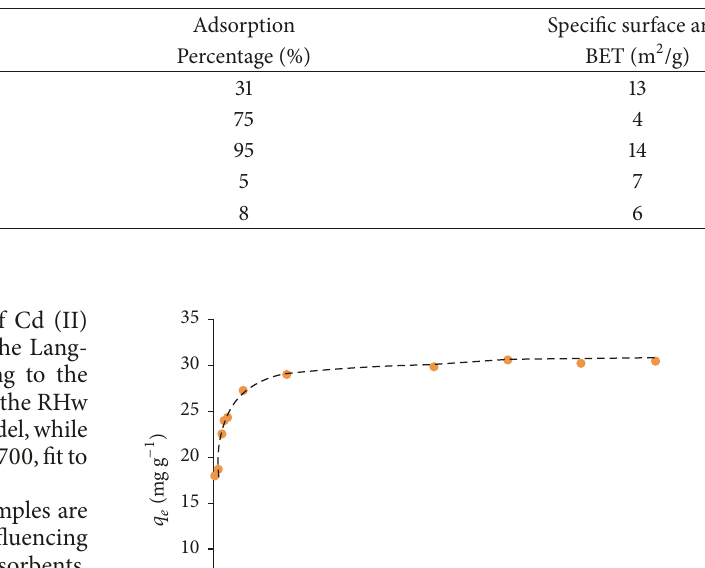
Table 4: Specific surface area, adsorption capacity, and percentage of Cd (II) adsorption onto adsorbent materials.